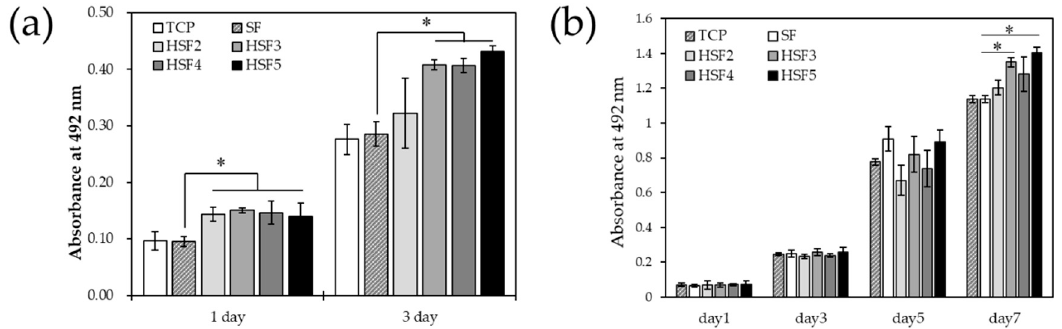
Figure 7. The proliferation of ( a ) HUVEC and ( b ) NHDF on a tissue culture plate (TCP), SF, and heparin-modified samples (HSF2, HSF3, HSF4 and HSF5) by MTS assay (* p < 0.05).